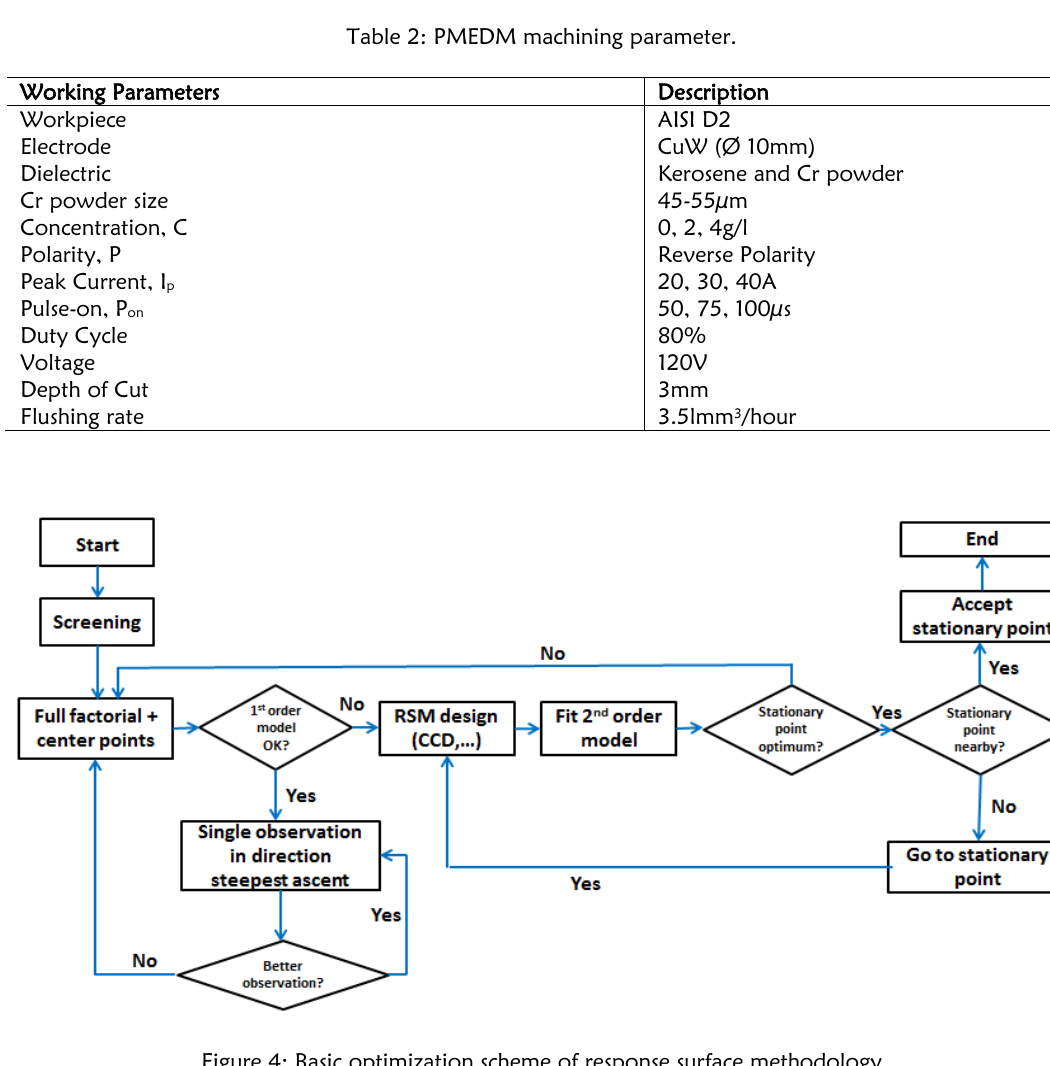
Figure 4: Basic optimization scheme of response surface